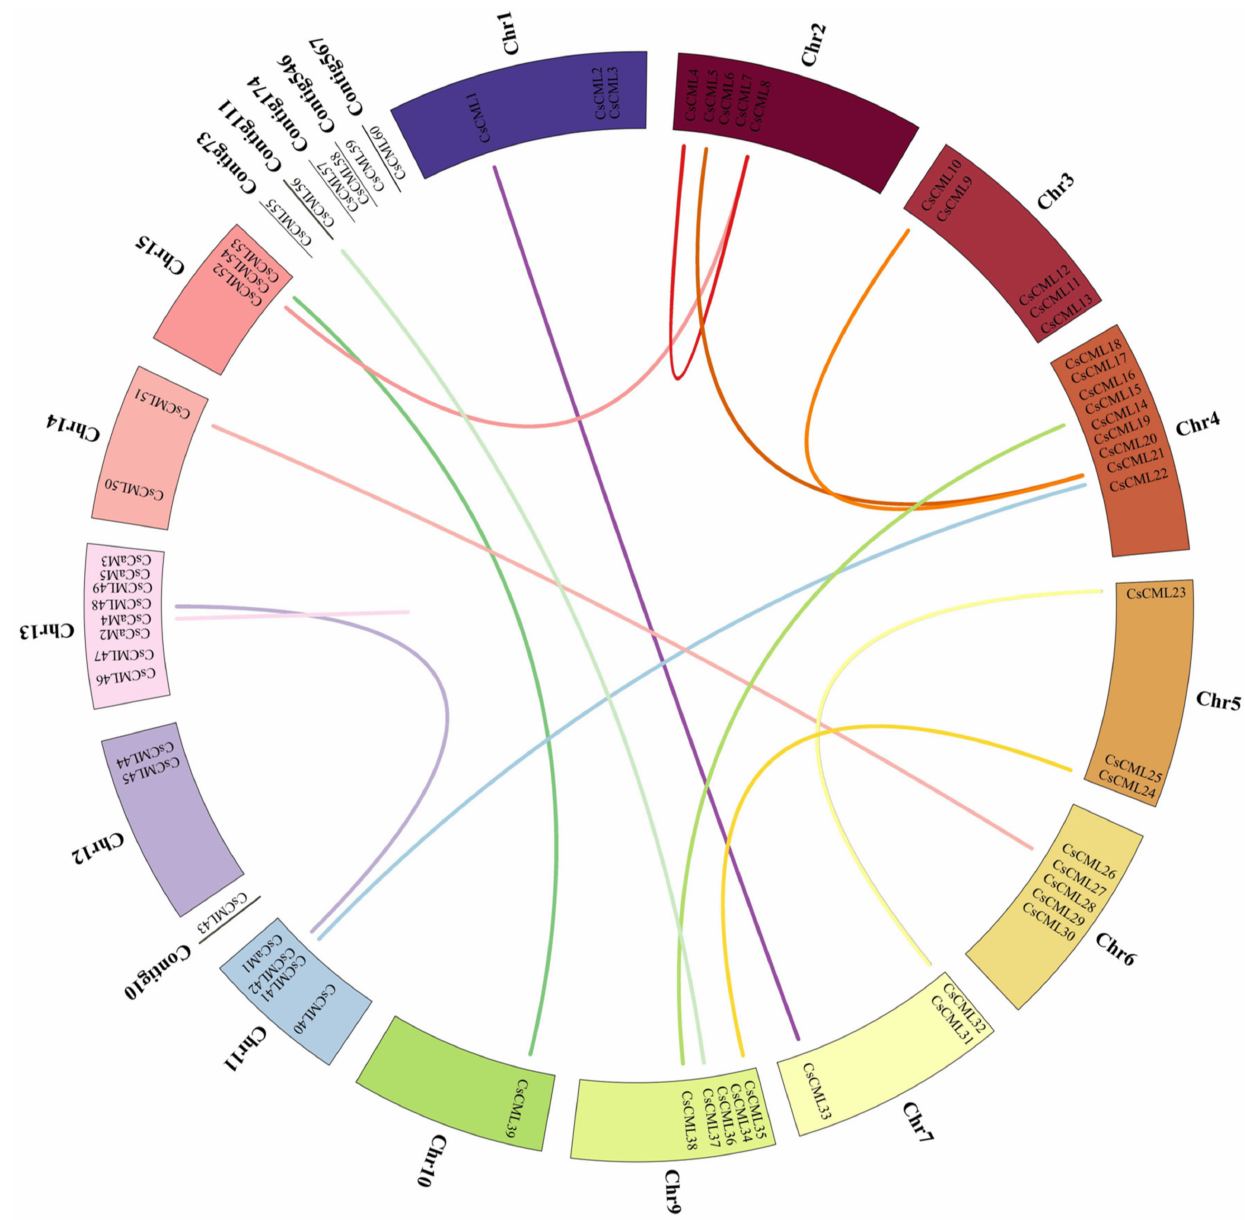
Figure 6. Collinearity analysis of tea CsCaM and CsCML genes. Among the 65 CsCaMs/CsCMLs genes, 14 segmentally duplicated tea plant CsCaM/CML genes were mapped onto 14